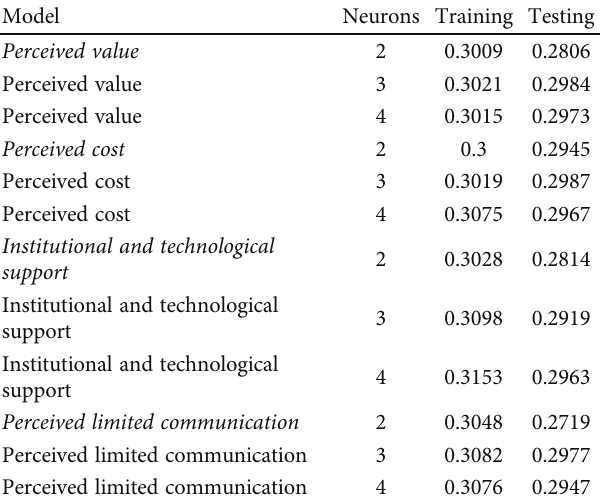
Table 7: RMSE values for MLP models with di ff erent numbers of neurons in the hidden layer.